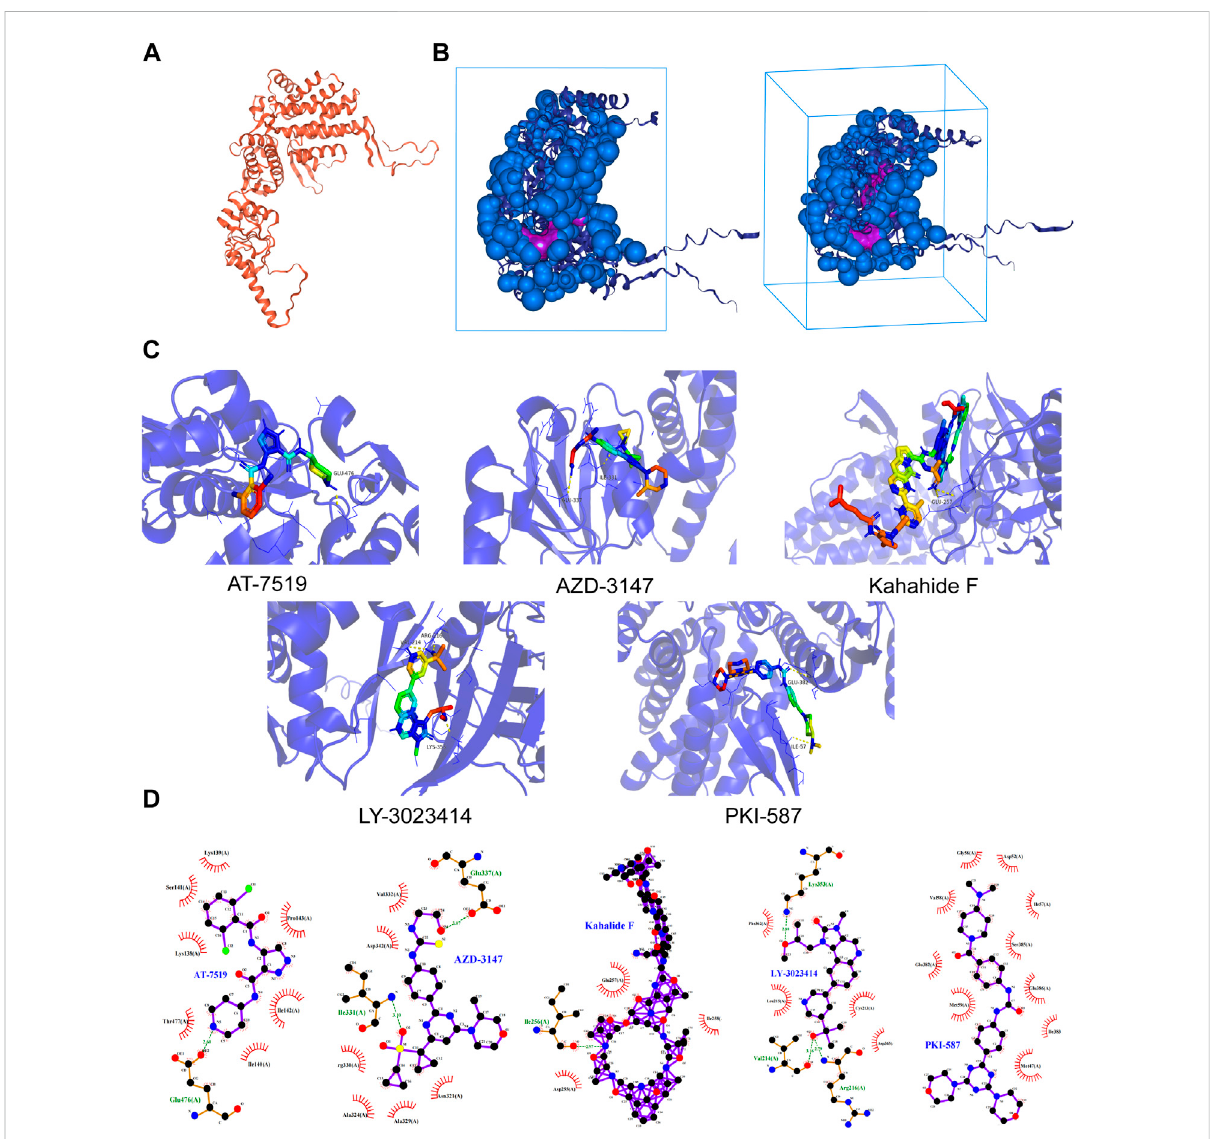
FIGURE 10 Predicting sensitive drugs for CCT3 protein. (A) Three-dimensional structure of CCT3 protein. (B) Predicted binding sites and box of CCT3protein. (C) TheinteractionbetweensensitivedrugsandCCT3proteinbyPyMolsoftware. (D) Thetwo-dimensionalstructureoftheinteraction force between the compound (middle) and the amino acid residues of CCT3 protein (green dotted lines represents the hydrogen